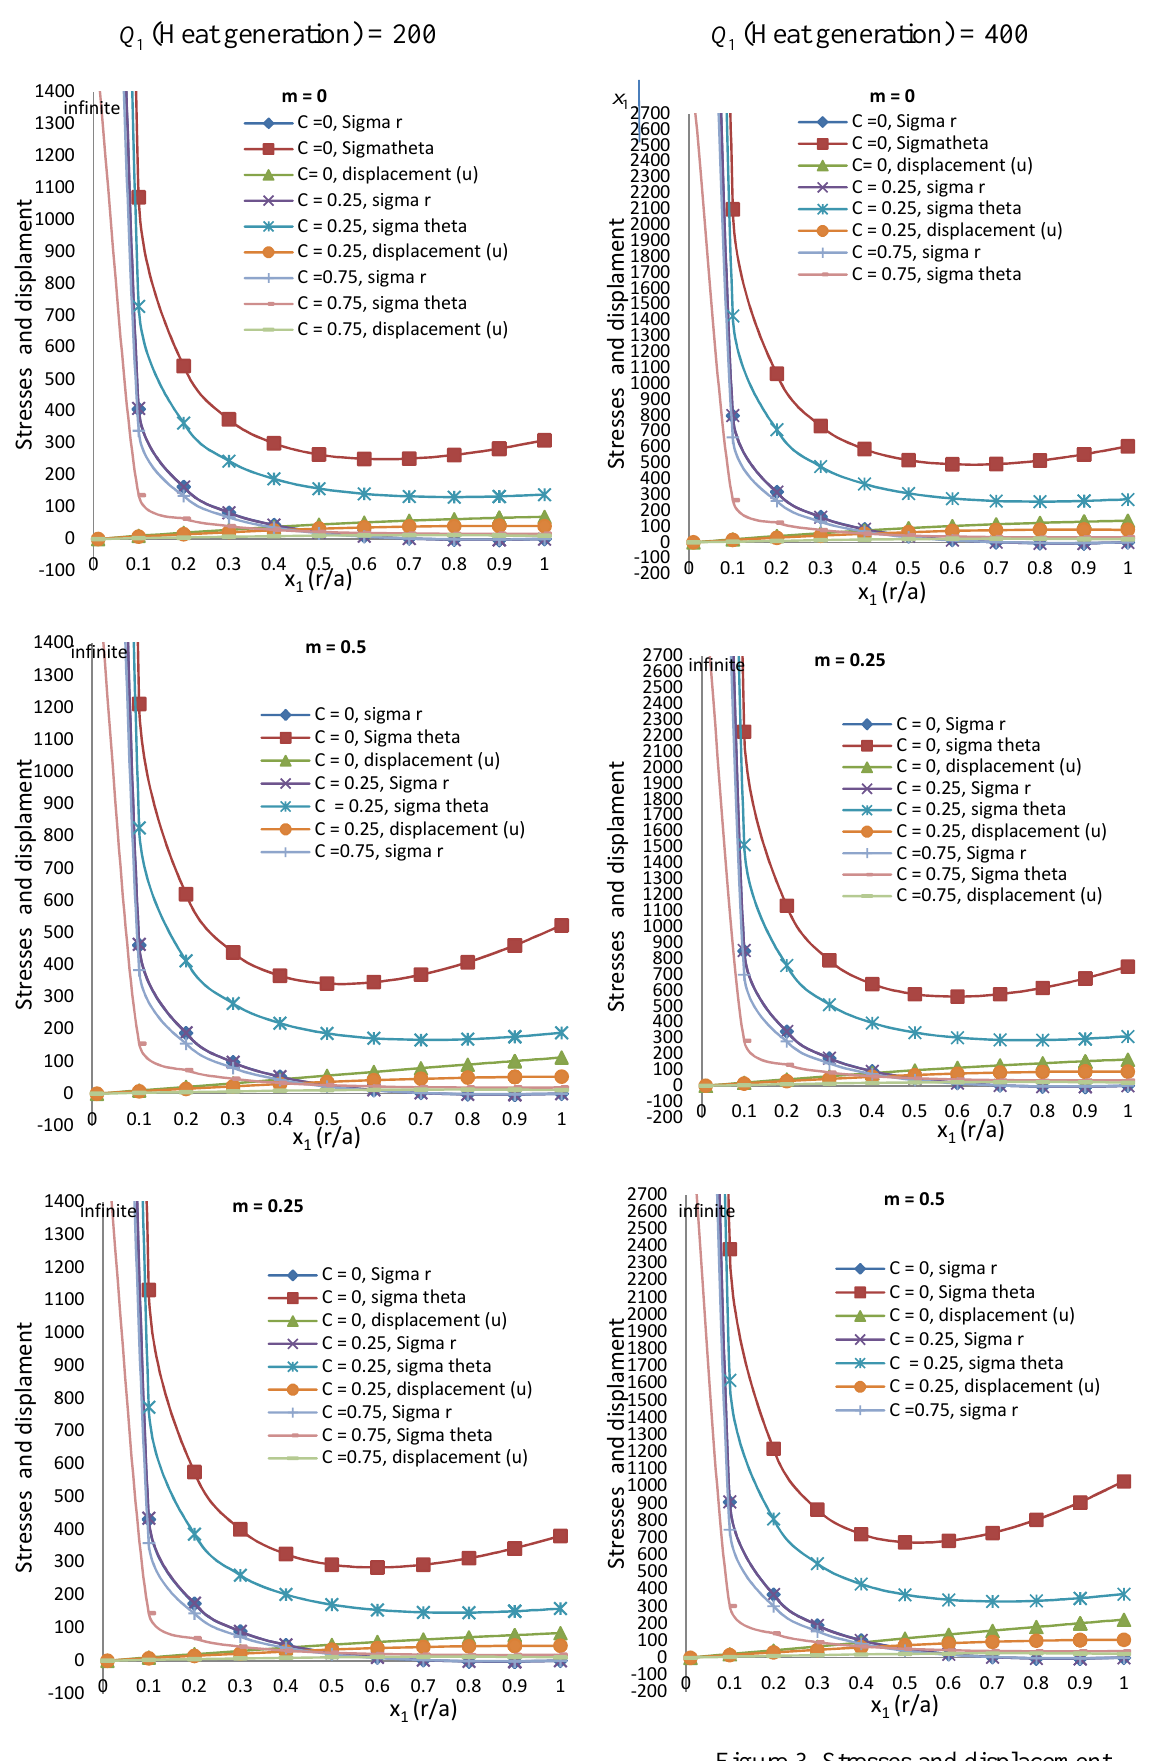
Figure 2. Stresses and displacement distribution in solid disk.